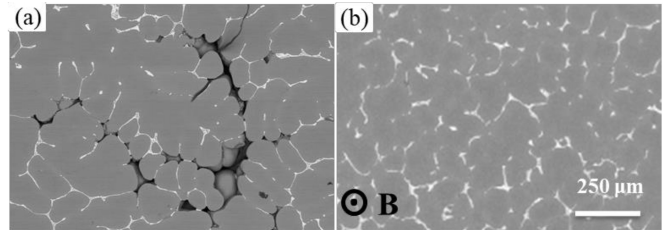
Figure 2. The SEM images showing microstructures in the as-cast Al alloys: ( a ) without and ( b ) with 48 mT TMF treatment. Shrinkage porosities (dark regions) are observed in the Al-alloy without TMF treatment. The direction of the TMF is indicated in ( b ) by point B, represents from inward to outside. Scales bar is the same for ( a , b